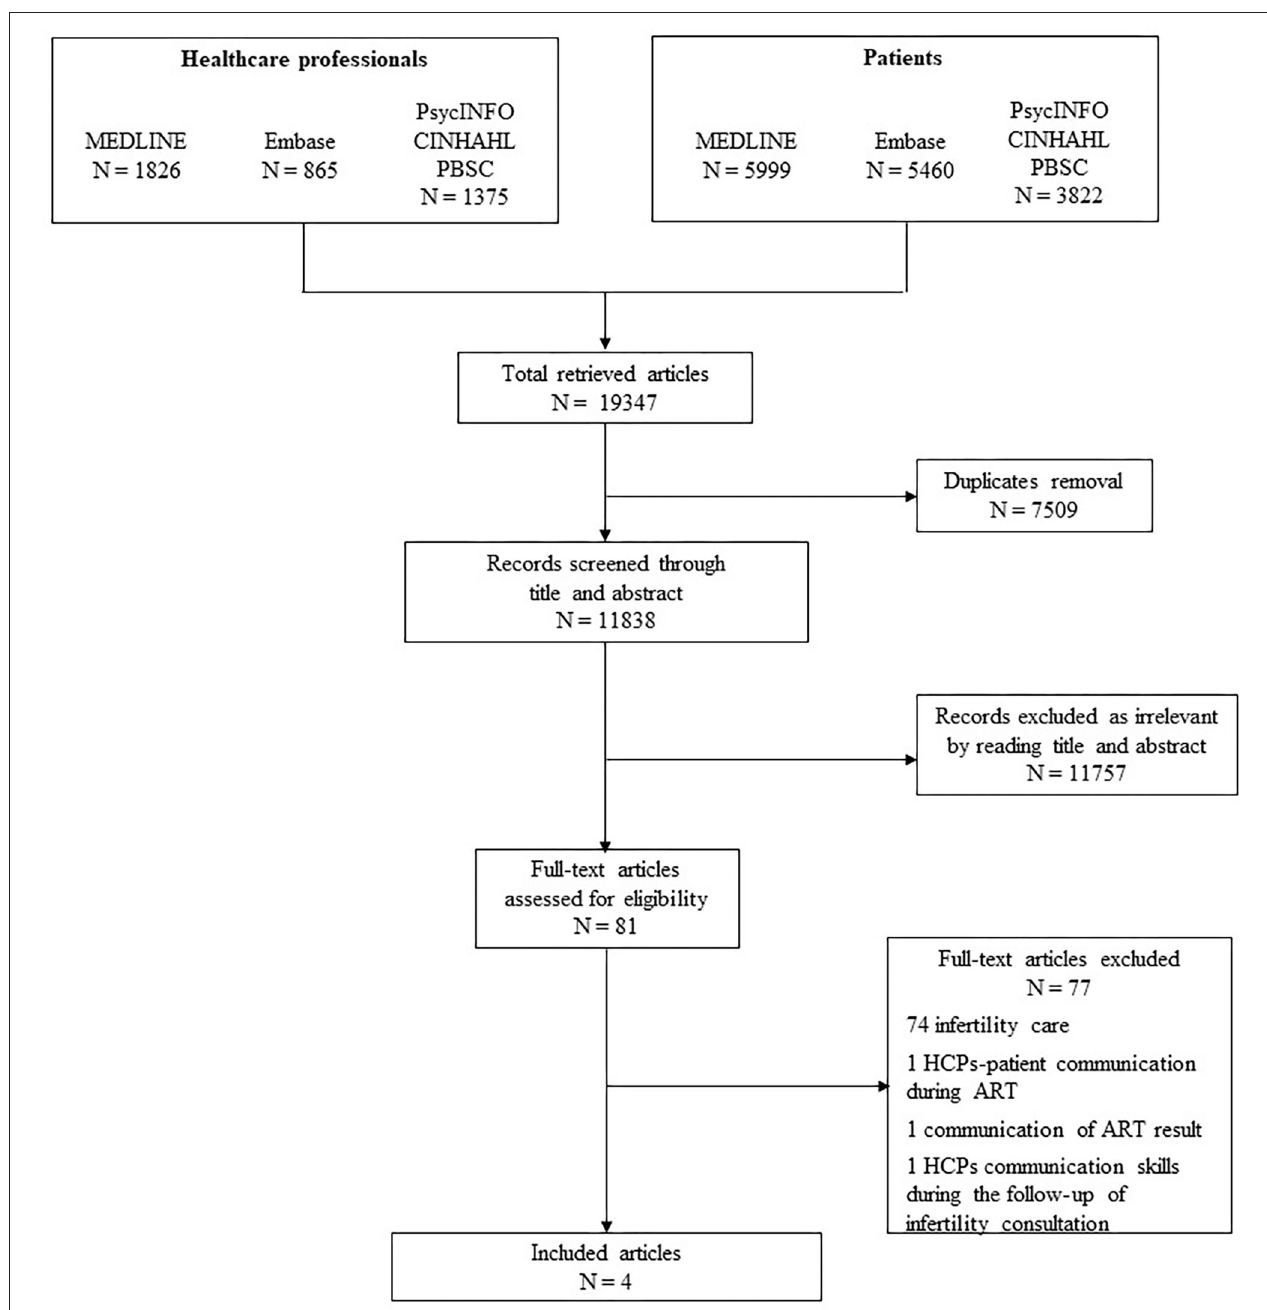
FIGURE 1 | Preferred reporting items for systematic reviews and meta-analyses PRISMA flowchart of search strategy